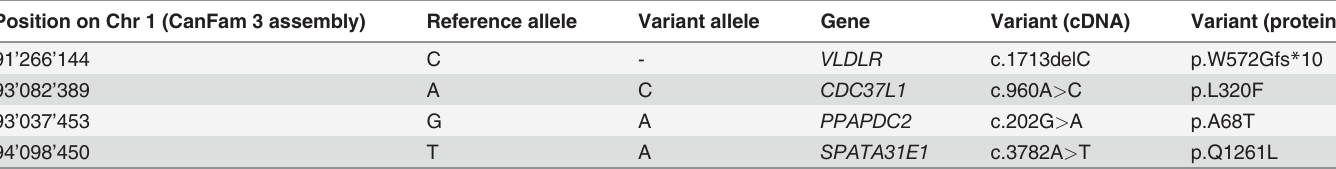
Table 2. Four non-synonymous variants in the critical interval of an affected Eurasier that were absent from 47 other dog genomes. Position on Chr 1 (CanFam 3 assembly)